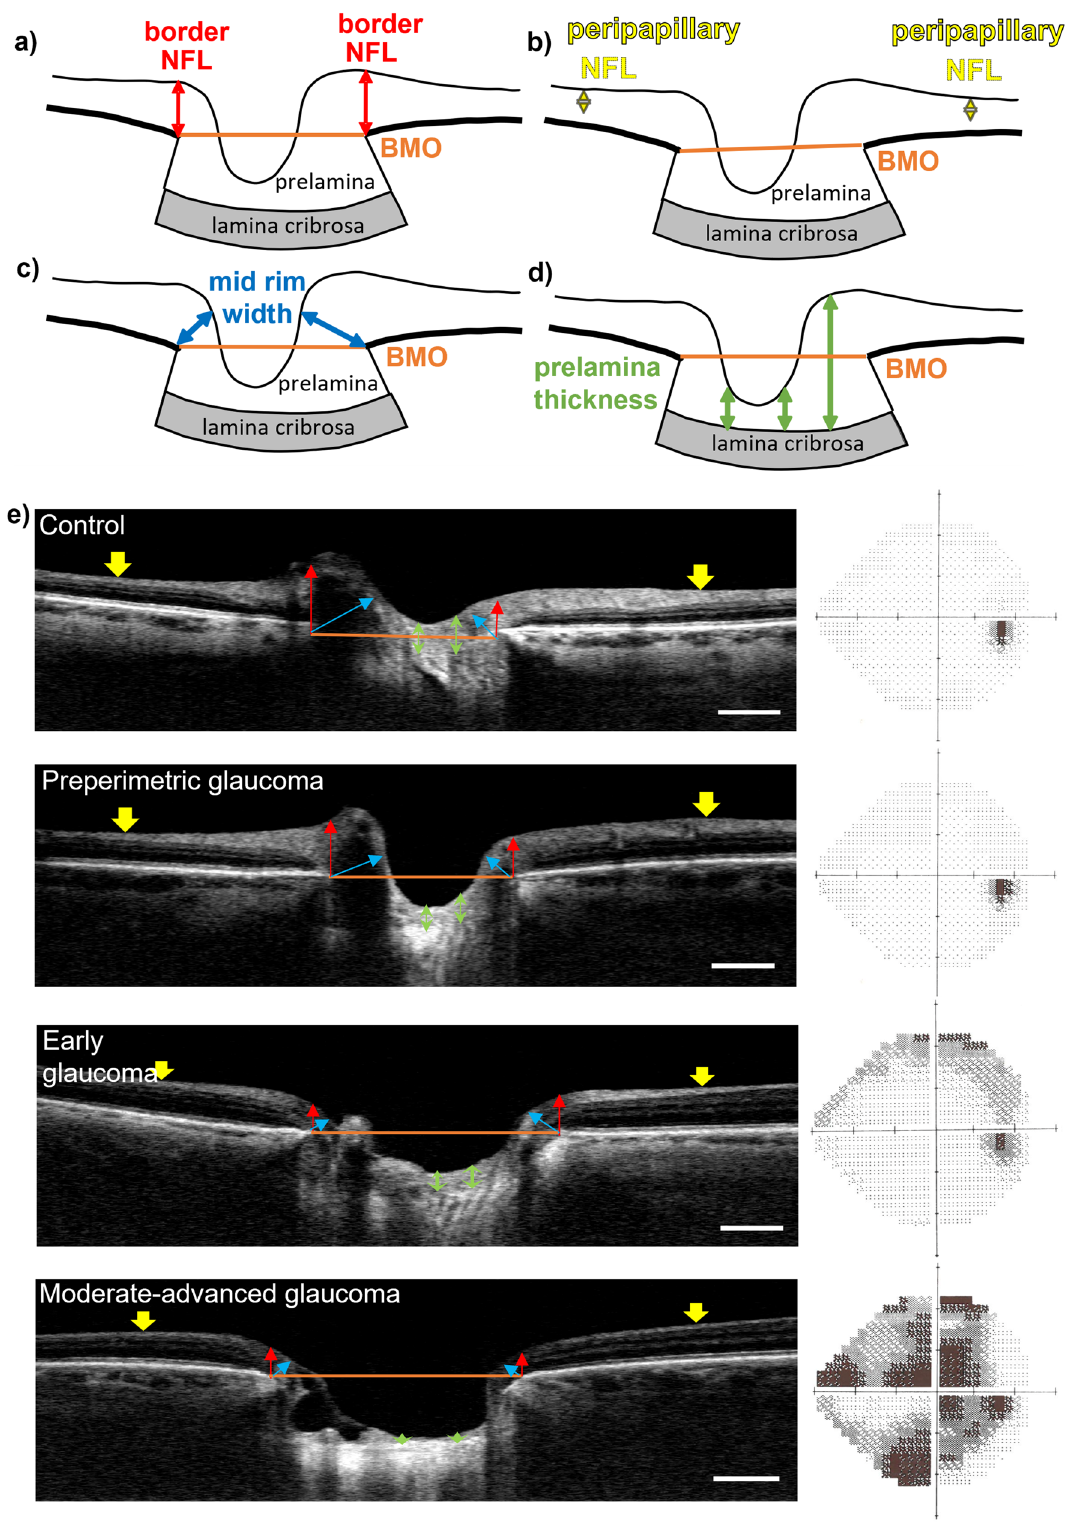
Figure 1. ( a ) Schematic optic nerve head (ONH) diagram depicting ( a ) measurement of border nerve fibre layer (bNFL); ( b ) peripapillary nerve fibre layer (pNFL) measured 1.7 mm from ONH centre; ( c ) minimum rim width (MRW); ( d ) prelamina thickness calculated as the difference between anterior lamina cribrosa (LC) and prelamina surface depths relative to Bruch’s membrane opening (BMO). ( e ) Representative OCT tomograms (inferior-nasal to superior-temporal axis) of optic nerve heads in Control, Preperimetric, Early Glaucoma and Moderate-advanced Glaucoma groups, with corresponding visual field plots. Axon-related parameters: border NFL (red arrows), position of peripapillary NFL measurement (yellow arrow heads), Bruch’s membrane opening (orange line), MRW (blue arrows), prelamina thickness (green arrows). Scale bar represents 500 µm. Visual field plots are normal for control and preperimetric groups; note that the black region on right hand-side represents the physiological blind spot. Increasing visual field loss is indicated, from early glaucoma to moderate-advanced groups, by the increased areas of grey and